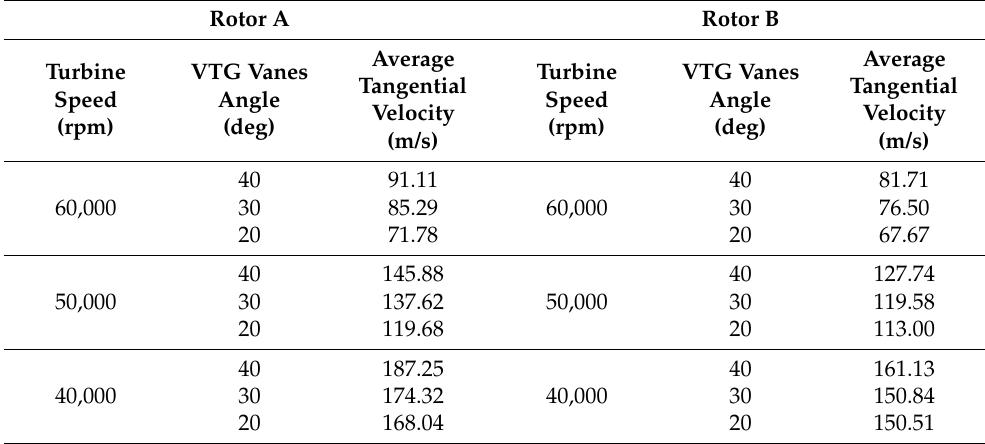
Figure 30. The area-averaged tangential velocity at the outlet from the second-stage rotor: ( a ) rotor A at 60,000 rpm, ( b ) rotor B at 60,000 rpm, ( c ) rotor A at 50,000 rpm, ( d ) rotor B at 50,000 rpm, ( e ) rotor A at 40,000 rpm, ( f ) rotor B at 40,000 rpm. Table 13. The average values of the second-stage rotor outlet absolute tangential velocity at different turbine speed and VTG vane